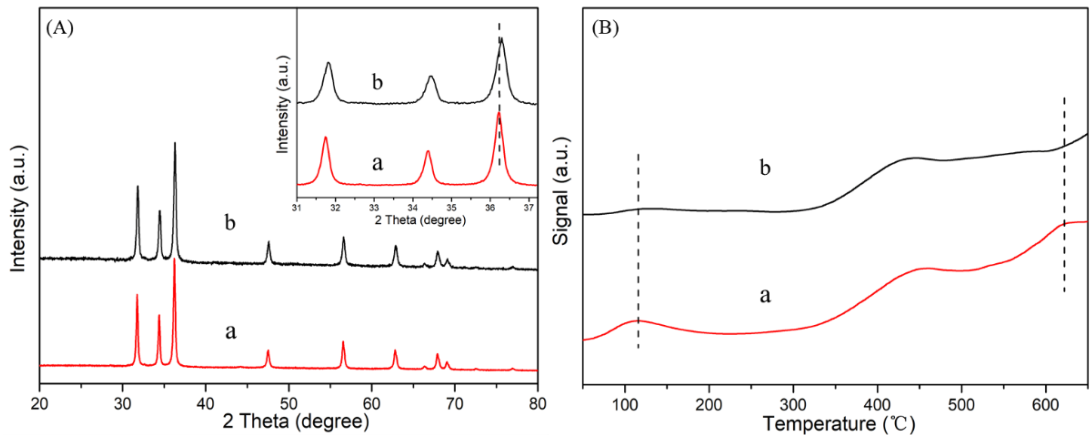
Figure 7. ( A ) XRD patterns of: (a) fresh ZnCo/NC-600 and (b) ZnCo/NC-600 after five cycles; ( B ) CO 2 -TPD profiles of: (a) fresh ZnCo/NC-600 and (b) ZnCo/NC-600 after five cycles.